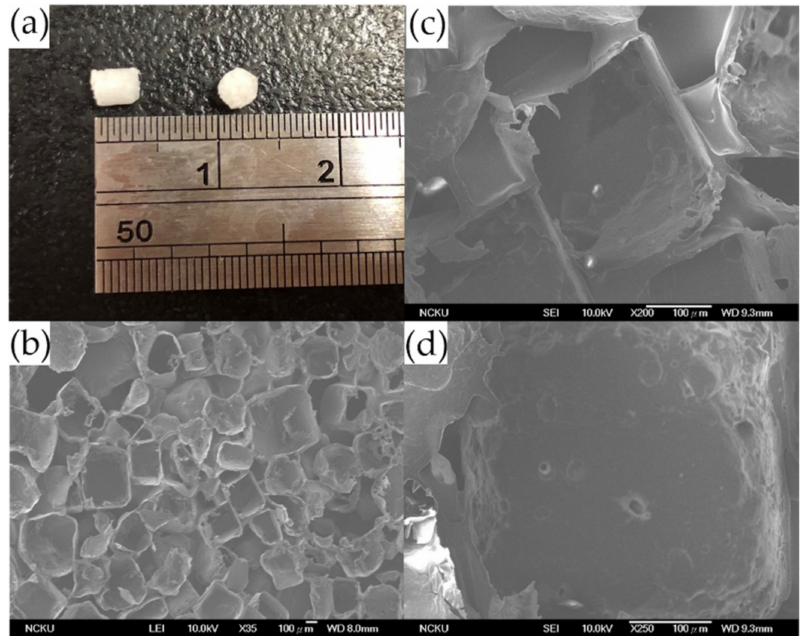
Figure 1. Characteristics of the PLGA scaffold. PLGA sponge scaffold ( a ), and scanning electron microscopy images of the PLGA structure under different magnifications: x35 ( b ); x 200 ( c ); and x 250, the interconnectivity of the PLGA scaffold ( d ). Scale bar 100 µ